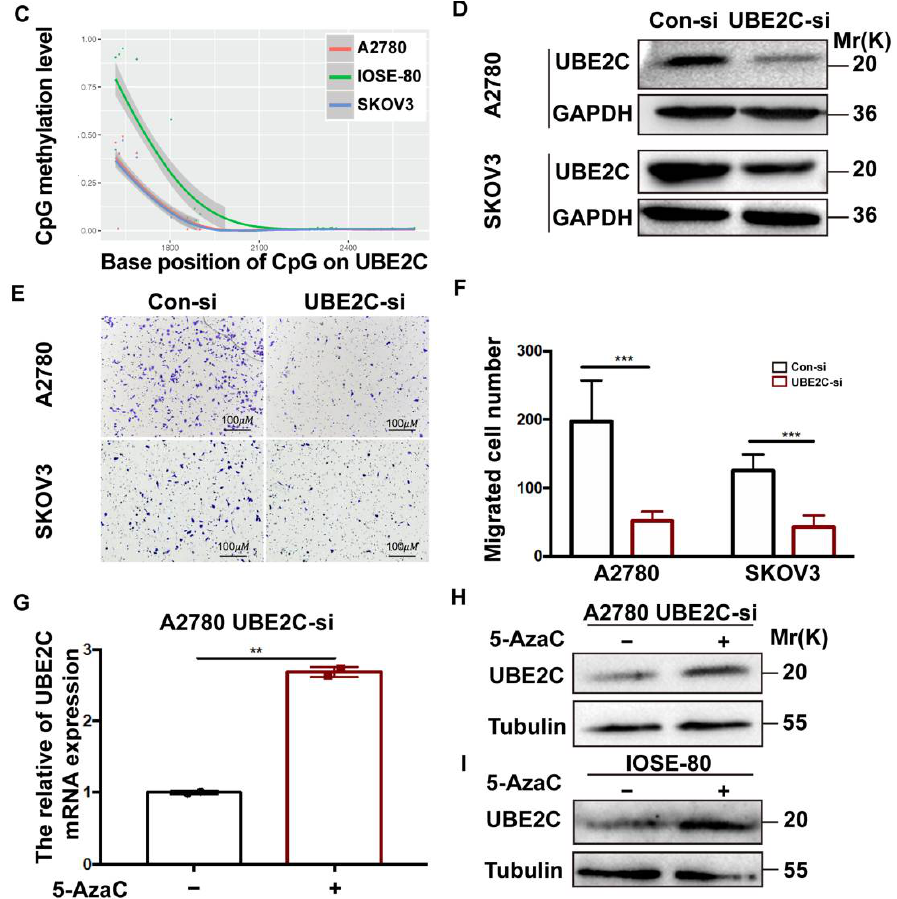
Figure 7. UBE2C promotes cell migration and hypomethylating agents regulate UBE2C expression. ( A ). Western blot analysis (tubulin was used as the loading control) of UBE2C expression in the normal ovarian epithelial cell line IOSE-80 and in ovarian cancer cell lines (A2780 and SKOV3). ( B ). The mRNA levels of UBE2C in IOSE-80, A2780, and SKOV3 cells according to qRT–PCR analysis. The data are representative of three independent experiments. ** p < 0.01, *** p < 0.001 vs. IOSE-80 cells; t -test. ( C ). The line chart of methylation levels of UBE2C for each sample (IOSE-80, A2780, and SKOV3) on each amplified fragment according to analysis of bisulfite sequencing PCR. ( D ). Western blot analysis (GAPDH was used as the loading control) of UBE2C expression in A2780 and SKOV3 cells following transfection with UBE2C-siRNA (UBE2C-si) or control-siRNA (Con-si). ( E , F ). Representative images ( E ) and the statistical chart ( F ) of migration of A2780 and SKOV3 cells transfected with UBE2C-si and Con-si. The data are representative of three independent experiments. *** p < 0.001 vs. Con-si; t -test. The scale bar indicates 100 µ m. ( G ). The mRNA expression levels of UBE2C in A2780 cells transfected with UBE2C-si and treated with or without 5-AzaC (5 µ M) for 72 h. DMSO was used as a vehicle. ** p < 0.01. ( H ). The protein expression levels of UBE2C in A2780 cells transfected with UBE2C-si treated with 5 μM 5-AzaC for 72 h. ( I) . The protein expression levels of UBE2C in IOSE-80, which treated with 5 μM 5-AzaC for 72 h.